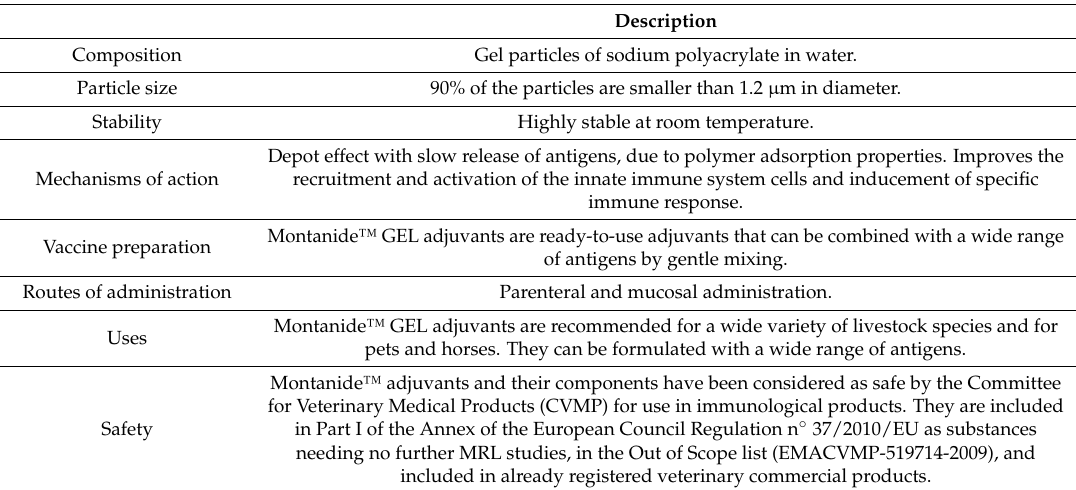
Table 1. General properties of Montanide™ GEL